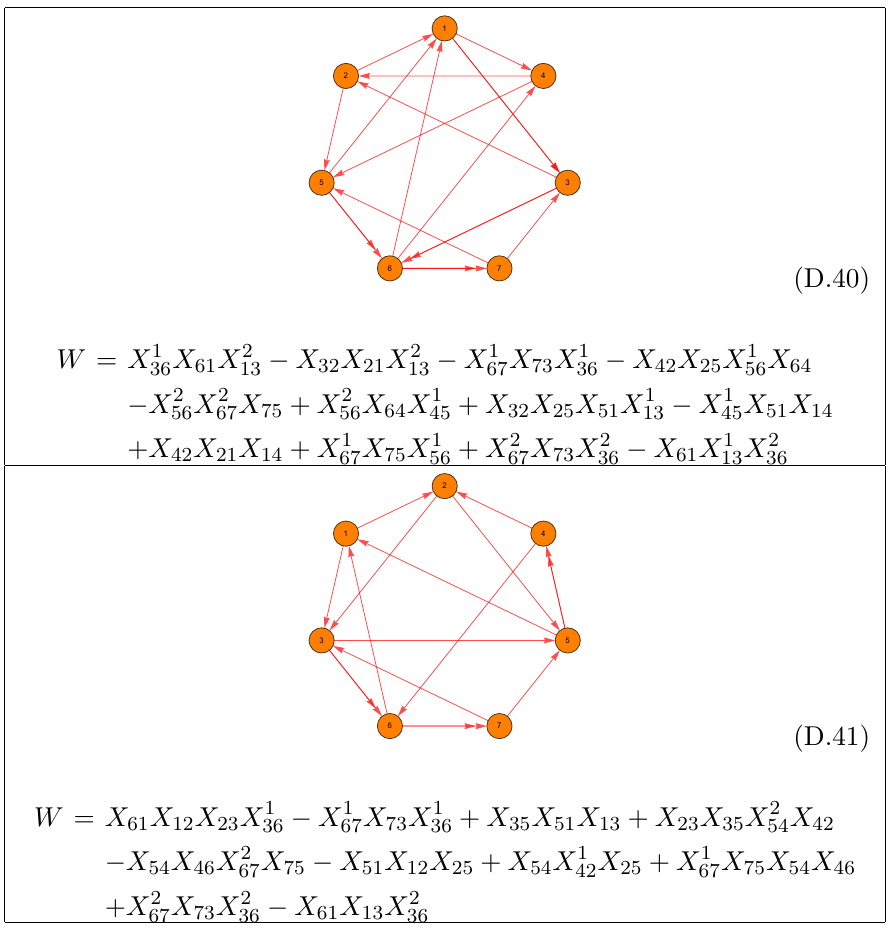
Table 6. The remaining toric phases of (5.12) in section